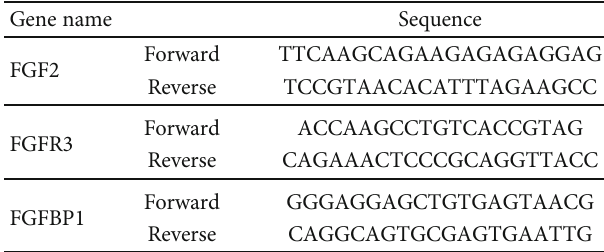
Table 2: PCR primer